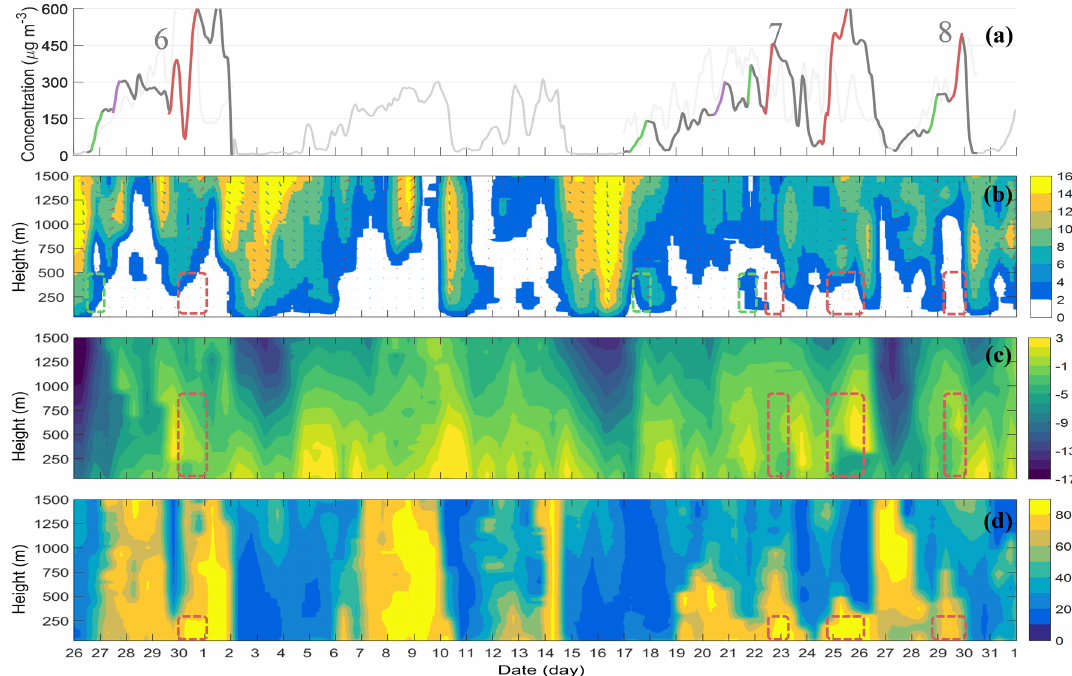
Figure 3. Temporal variations in urban mean PM 2 . 5 and vertical distributions of meteorological factors in December 2015. (a) PM 2 . 5 mass concentration (dark gray or gray: Beijing; light gray: Baoding); (b) winds (vectors; red vectors: southwesterly winds) and wind velocity (shadings; units: ms − 1 ); (c) temperature (shadings; units: ◦ C); (d) RH (shadings; units: %). Green boxes: rising processes; red boxes: cumulative explosive